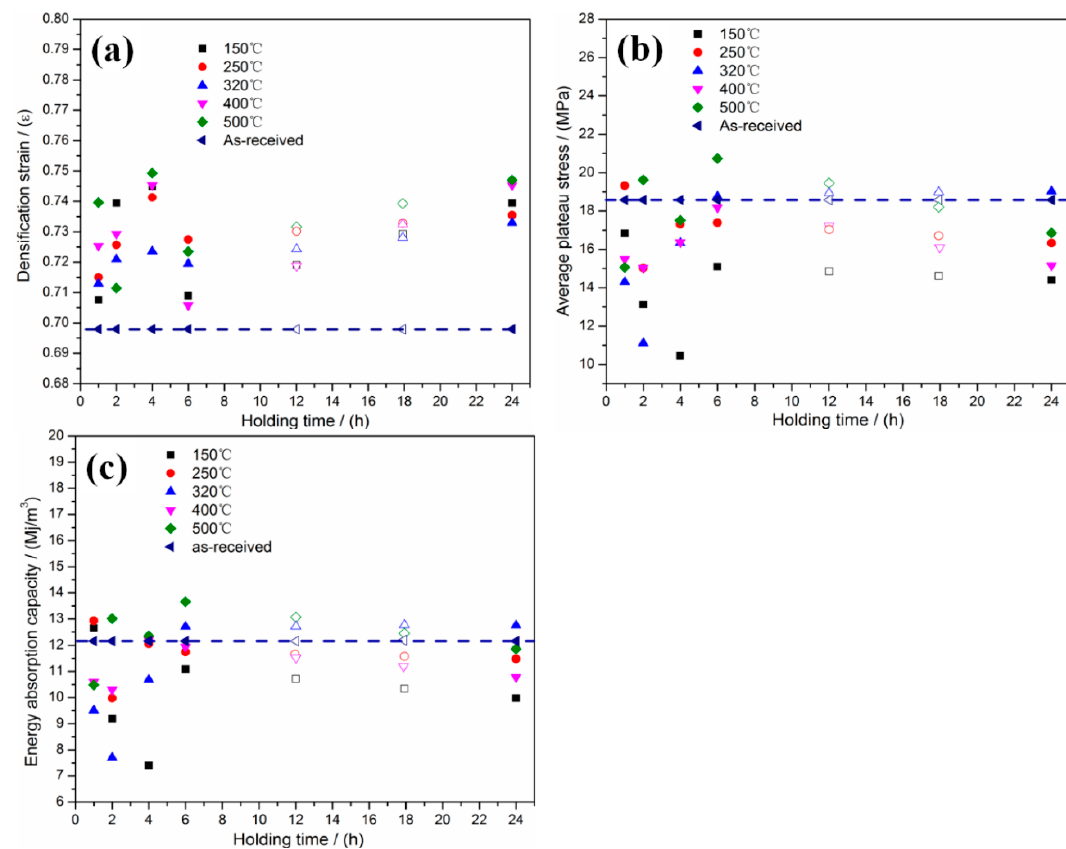
Figure 9. Densification strain ( a ), average plateau stress ( b ) and energy absorption capacity ( c ) of the foams.